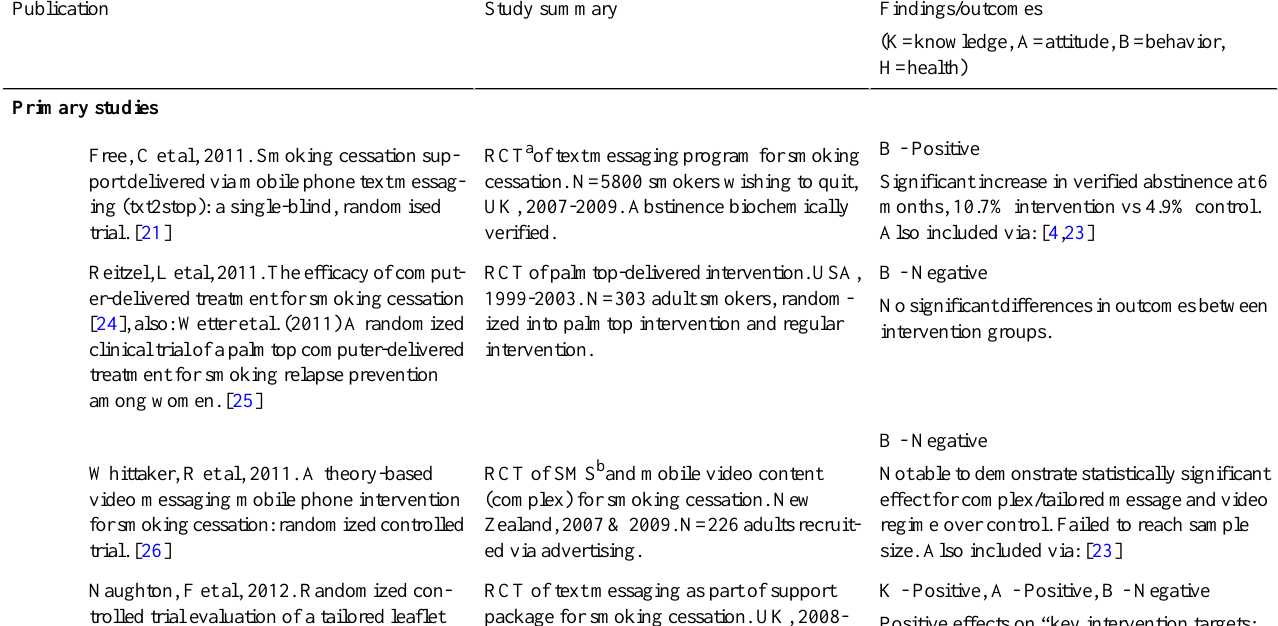
Table 2. Summary of smoking cessation reviews.